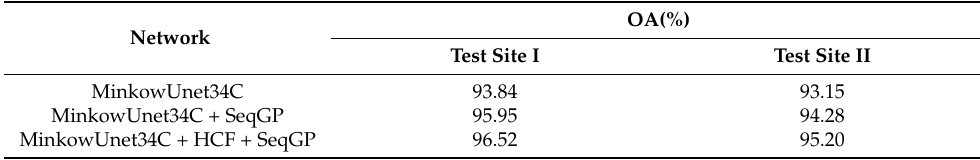
Table 4. Ablation studies of the proposed